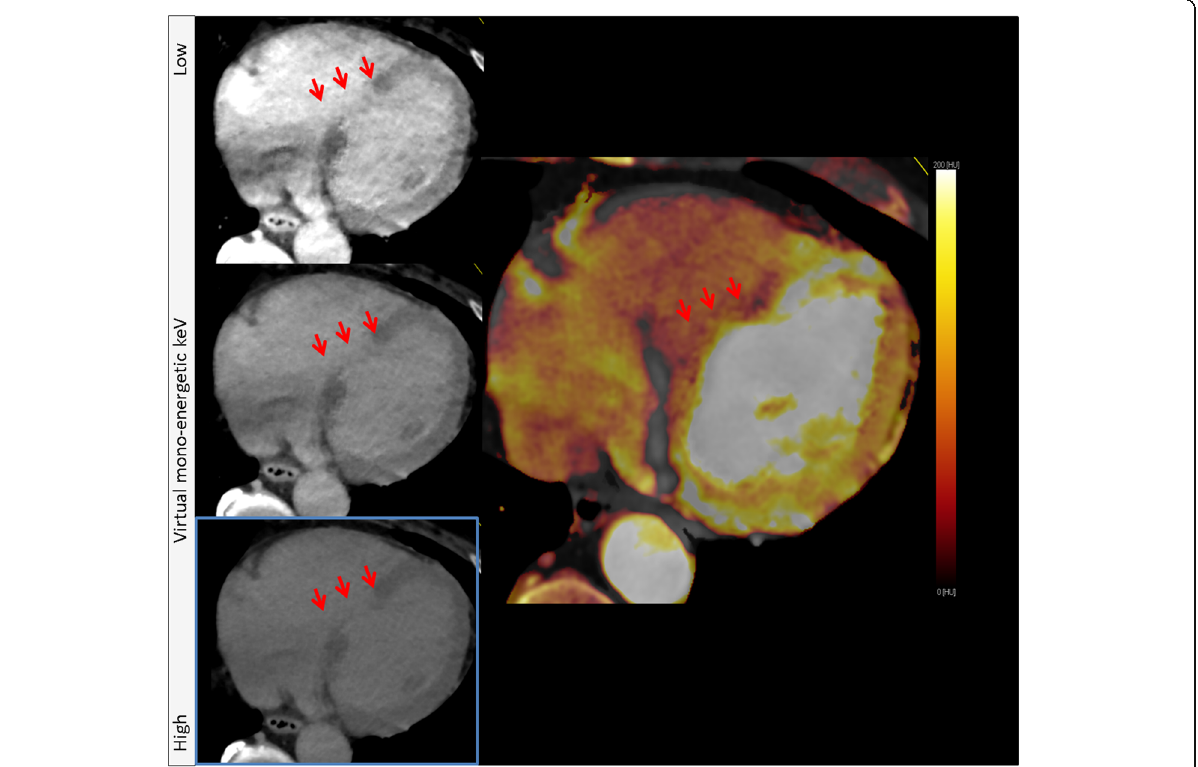
Fig. 7 The left images show different level kV LIE-CT images ordered from low to high kV, with the image in the blue box representing the traditional SECT LIE-CT acquisition. The right image represents the iodine map. The red arrows indicate hyper-enhancement of the infarcted areas of the